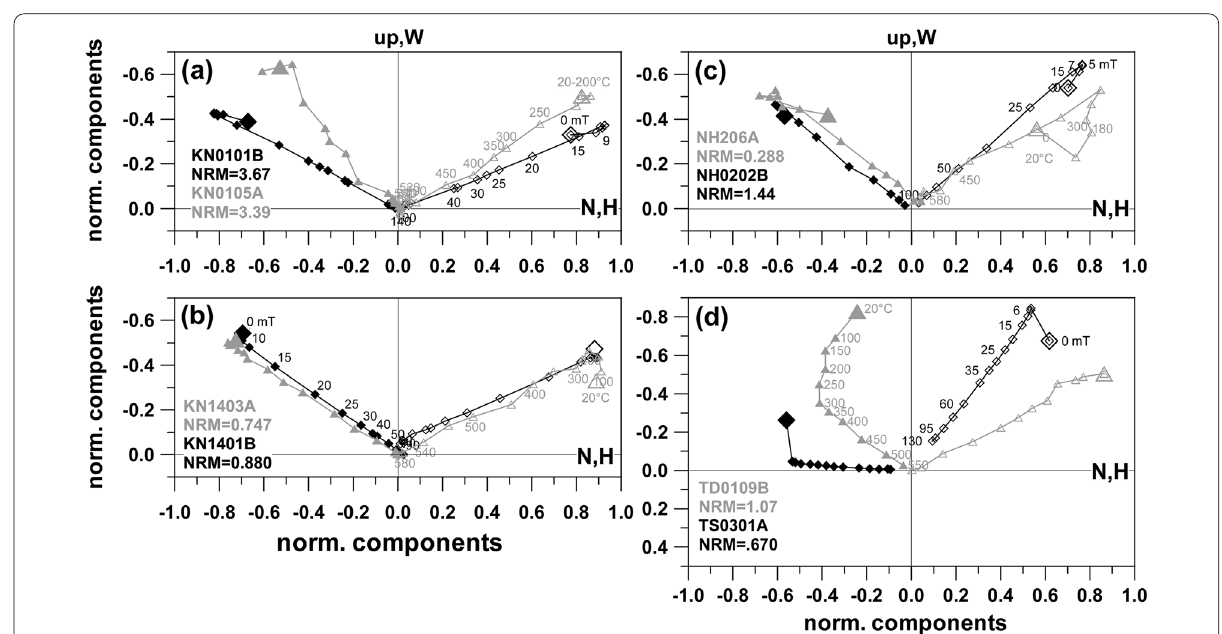
Fig. 7 Demagnetizations plots for a Klöch quarry, b Zaraberg, c Neuhaus and d Tieschen sites. Same representation as in Fig.